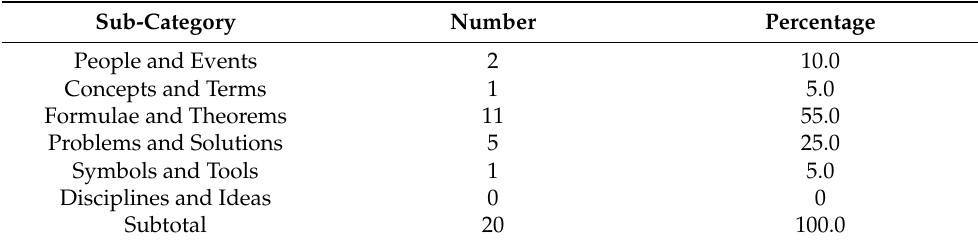
Table 3. The content distribution of the category of Historical Topics